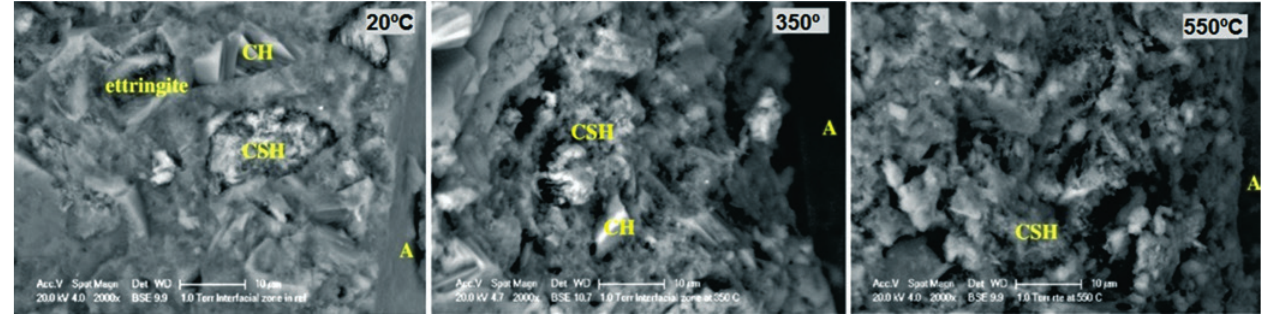
Concrete at ambient